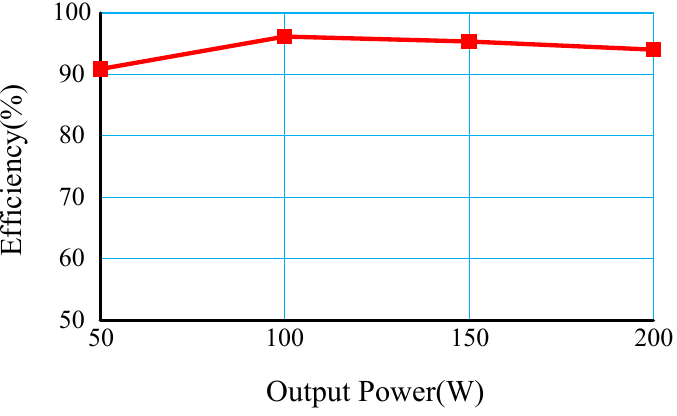
Figure 16. Measured efficiency under four load levels of